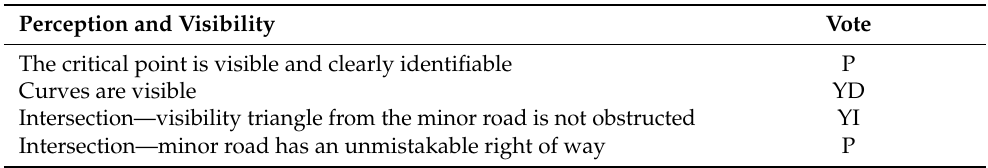
Table 6. Evaluations of the “perception and visibility” investigation topic. Perception and